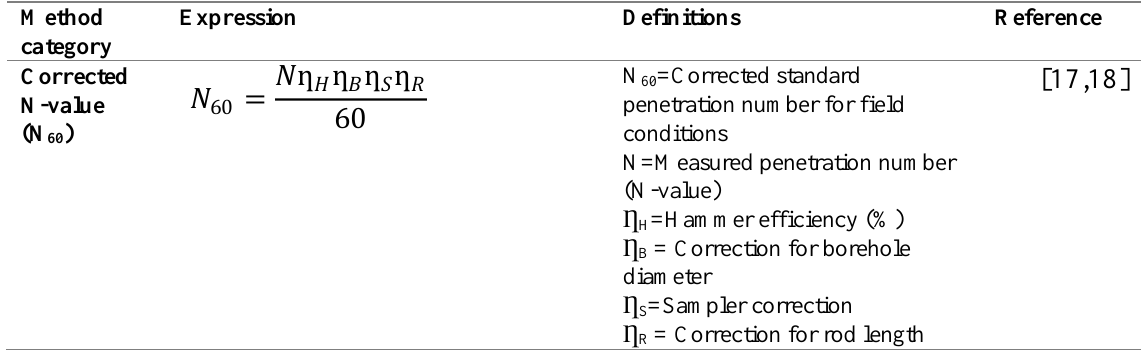
A nalytical models for settlement